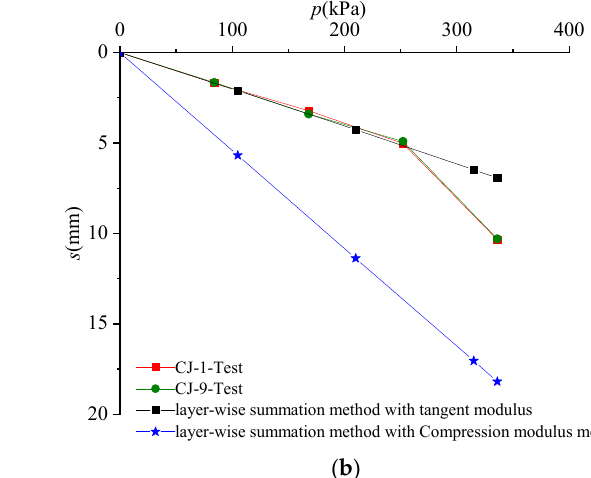
Figure 7. Comparison of calculated and measured p – s curves: ( a ) midpoint of the boundary line; and ( b ) corner point.